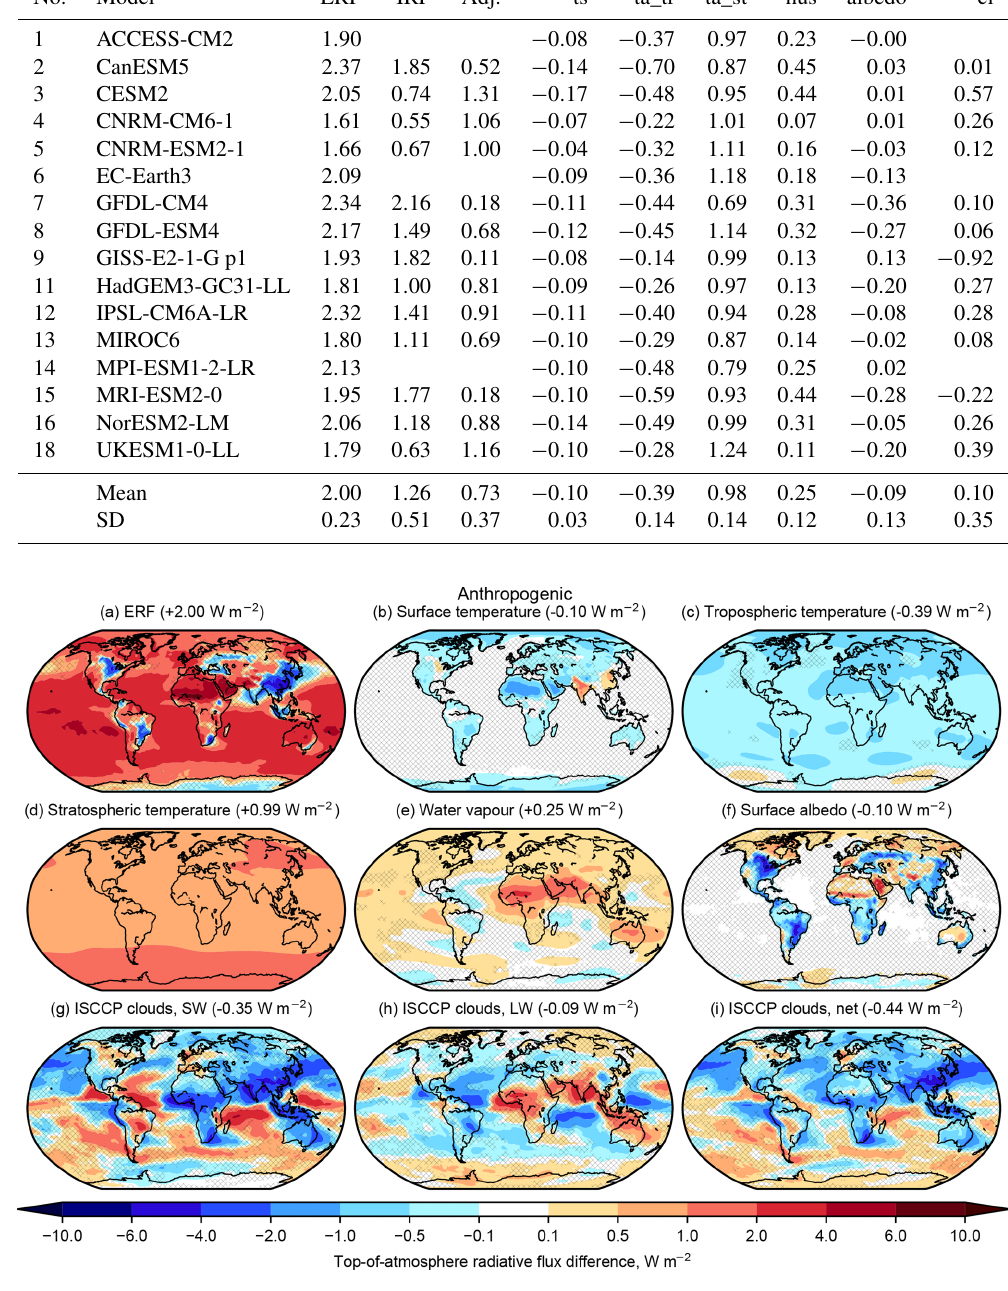
Figure 13. As Fig. 6 but for present-day anthropogenic